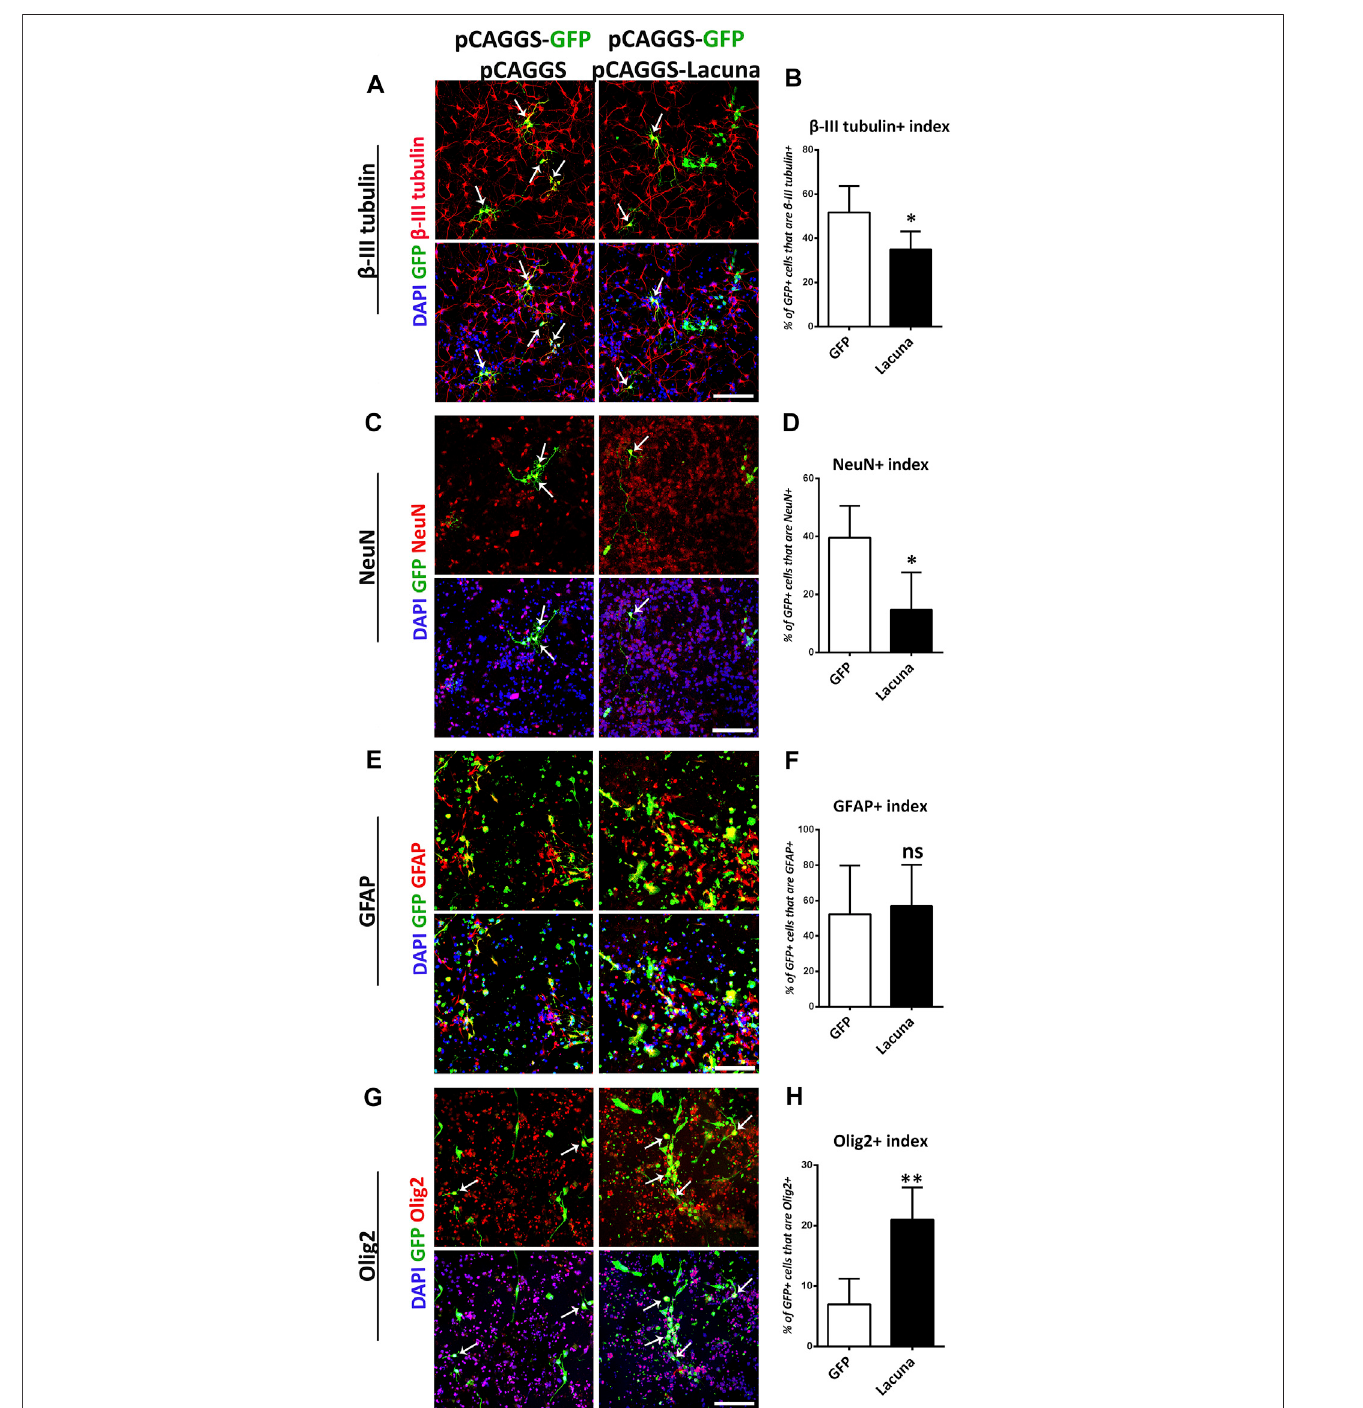
FIGURE3| Lacuna overexpressioninhibitsneuronaldifferentiationofmouseNeuralStemCells. (A) Lacuna andControltransfectedmouseNeuralStemcellswere immunostained for β -III tubulin(red) and GFP (green) and labeled withDAPI. Arrows indicate β -III tubulin/GFPdouble positivecells. Scale bar:100 μ m. (B) Quanti fi cation of β -IIItubulinpositivecellsintransgenepositivemouseNeuralStemcells(GFP:51.73 ± 5.355%, Lacuna :34.91 ± 3.671%, p < 0.05, N (cid:2) 5independentexperiments,in total 498 cells for Control condition and 602 cells for Lacuna condition). (C) Lacuna and Control transfected mouse Neural Stem cells were immunostained for NeuN (red), GFP (green) and labeled with DAPI. Arrows indicate NeuN/GFP double positive cells. Scale bar: 100 μ m. (D) Quanti fi cation of NeuN positive cells in transgene positive mouse Neural Stem cells (GFP: 39.58 ± 4.913%, Lacuna : 14.74 ± 6.426%, p < 0.01, N (cid:2) 5 independent experiments, in total 280 cells for Control conditionand227cellsfor Lacuna condition). (E) Lacuna andControltransfectedmouseNeuralStemcellswereimmunostainedforGFAP(red),GFP(green)andlabeled